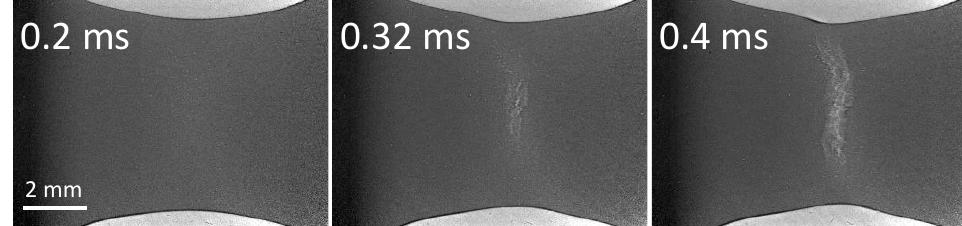
Figure 4. X-ray images of Scalmalloy specimen (printed 0° flat) under tension in SHTB. Image series captured by Shimadzu HPV-x2 based ultra-high speed X-ray detector at 1.14 MHz frame rate (with 880 ns inter-frame temporal sampling and captured with an exposure time of 200 ns) and a pixel count of 400 × 250 pixels for each of 128 acquired frames. From left to right, different timestamps capturing the formation of crack to fracture. White contrast in these radiographs represent high intensity X-rays. The aspect ratio of the images are adjusted for illustration purposes.